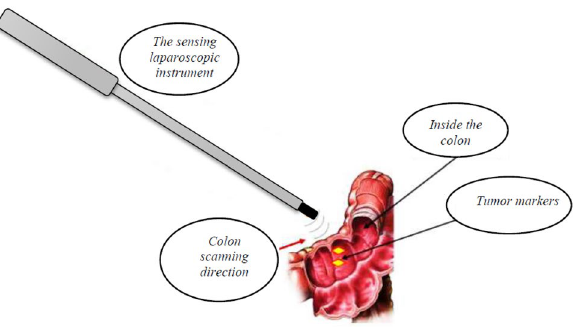
Figure 1. Principle of tumor detection by the complex formed from the sensing laparoscopic instrument and the endoscopically attached metallic tags—tumor